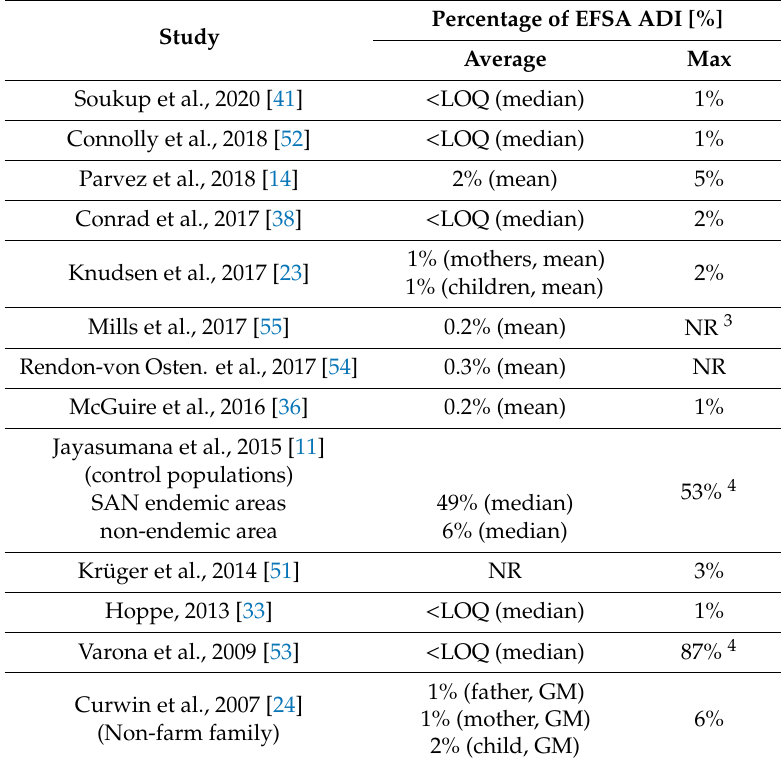
Table 3. The glyphosate concentrations in human urine samples (average and maximum values) from the non-occupationally exposed studies (Table 2) compared to the EFSA ADI 1 using a 1% urinary excretion fraction 2